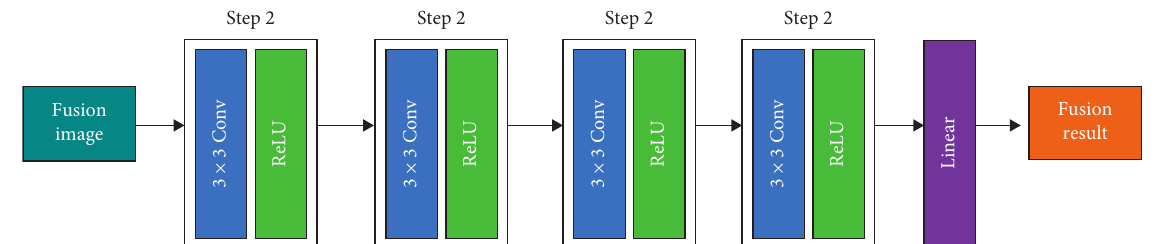
Figure 4: The structure of the discriminator in